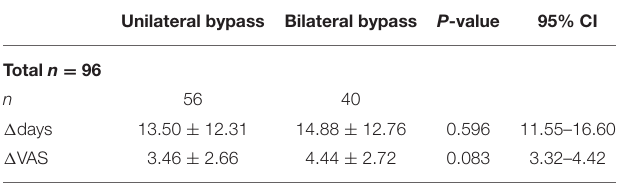
TABLE 7 | Intensity and frequency of headaches divided by the lateral of surgical revascularization with changes in the frequency ( 1 days) and intensity of headaches ( 1 VAS) after revascularization surgery.